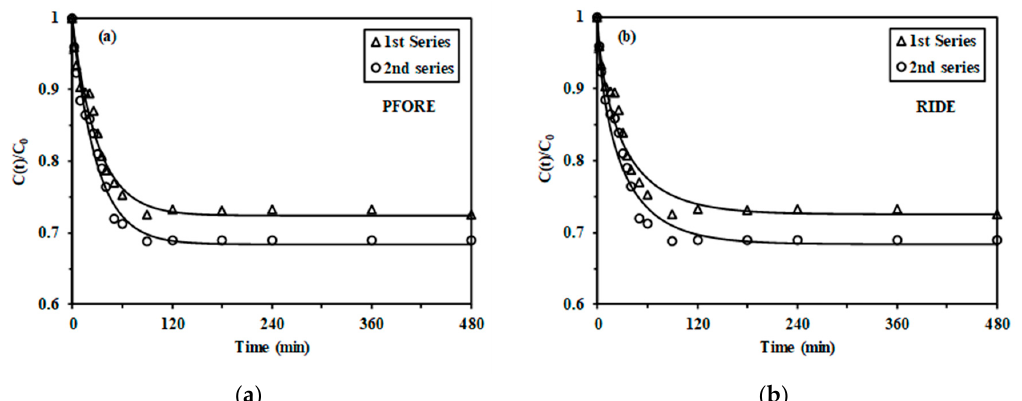
Figure 3. Uptake kinetics for Sr(II) removal using AO-APEI sorbent. Modeling of kinetic profiles with the PFORE ( a ) and the RIDE ( b ) models (pH 0 : 6.0; pH eq : 7.1; SD: 0.2 g L − 1 ; C 0 : 55.5 and 50.0 mg Sr L − 1 for 1st and 2nd series, respectively; room temperature: 25 ± 1 °C; agitation speed: 140 rpm). Table 1. Uptake kinetics for Sr(II) sorption onto AO-APEI. The parameters of the models. Model Parameter 1st Series 2nd Series